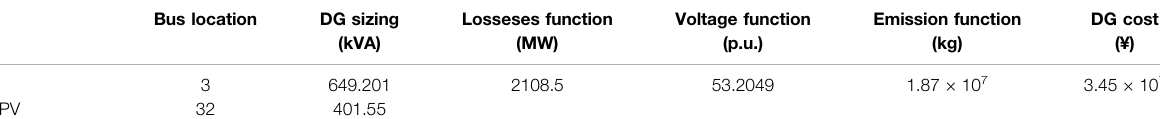
TABLE 1 | Optimization results of MOPSO.